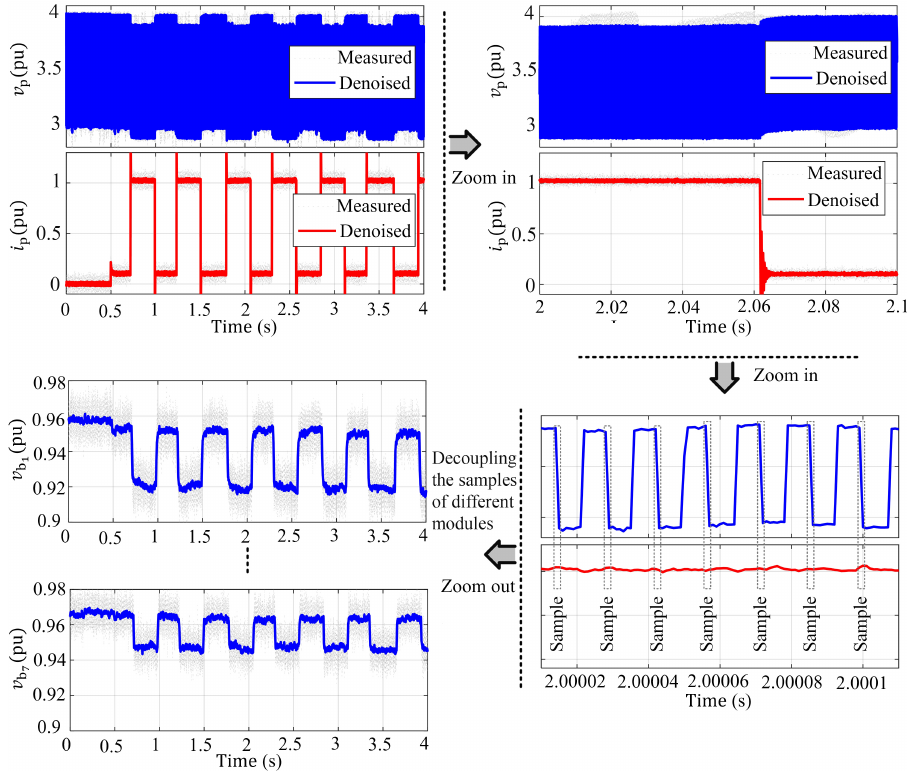
Figure 6. The decoupling algorithm and the estimation